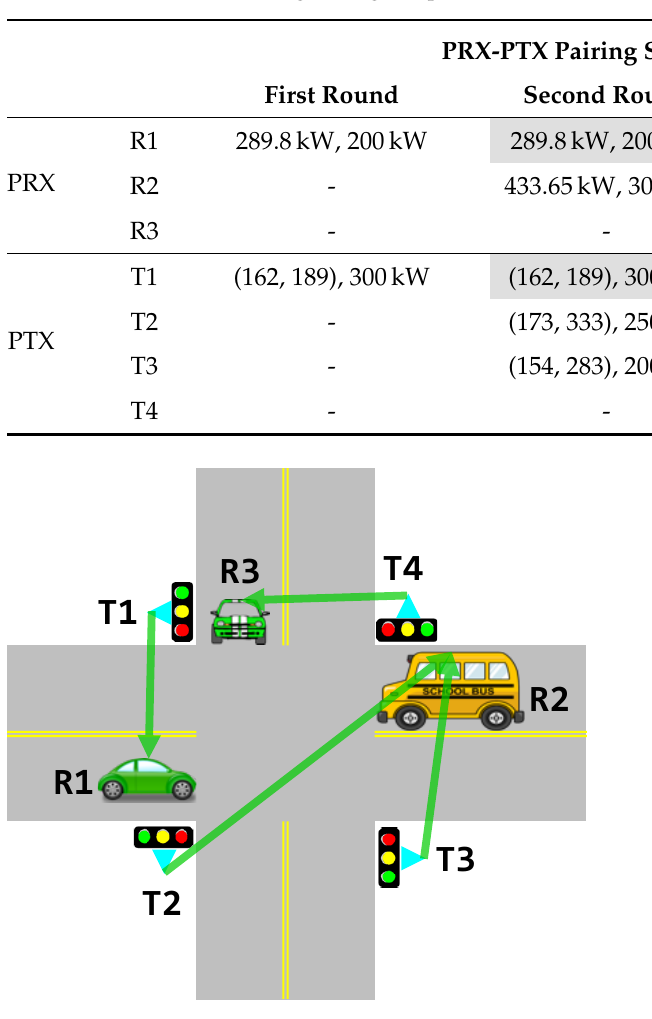
Table 7. Results of WPC using the highest power-based PTX selection algorithm.